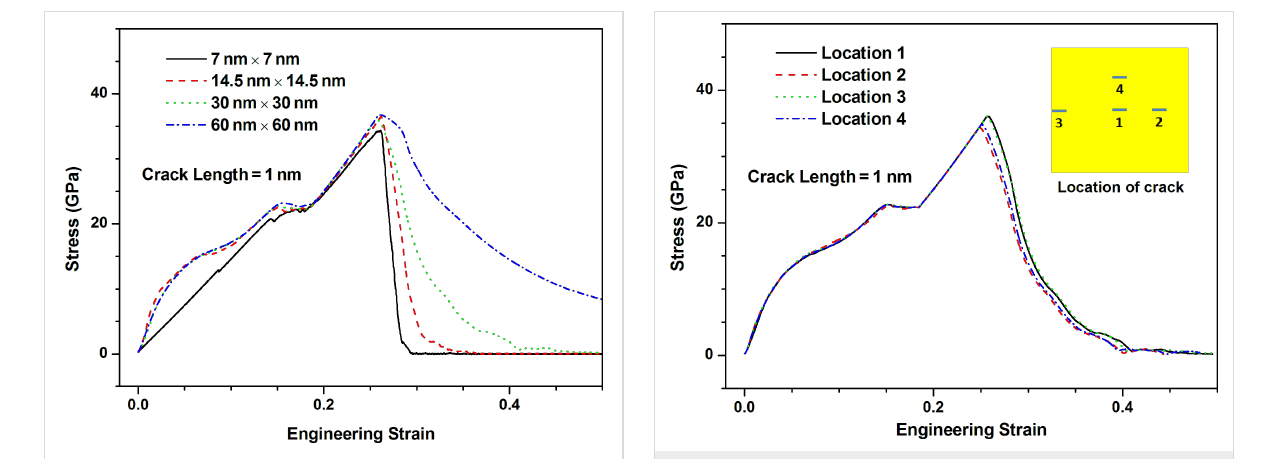
Figure 9: The stress–strain curves along armchair direction of MoS 2 sheet with the crack of 1 nm length under four sizes: 7 nm × 7 nm; 14.5 nm × 14.5 nm; 30 nm × 30 nm; 60 nm × 60 nm.